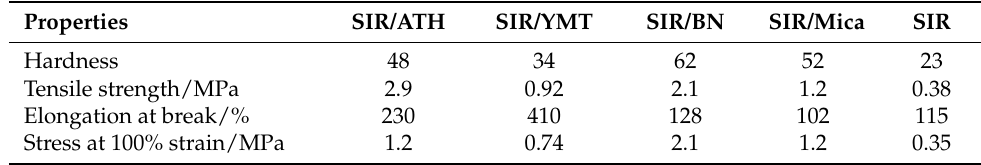
Table 2. Mechanical properties of SIR composites with various fillers. Properties